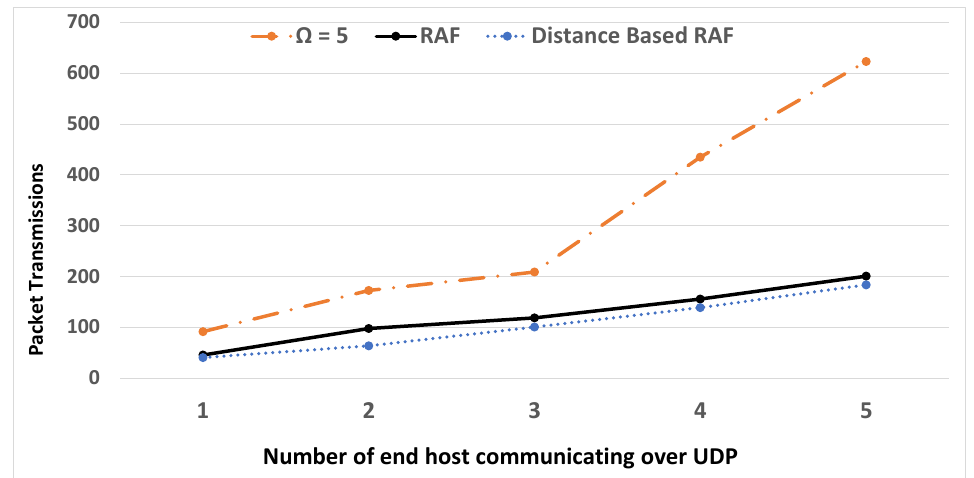
Figure 6. Control packet average